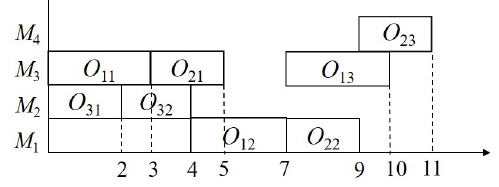
Figure 2. Illustration of the machine assignment process.